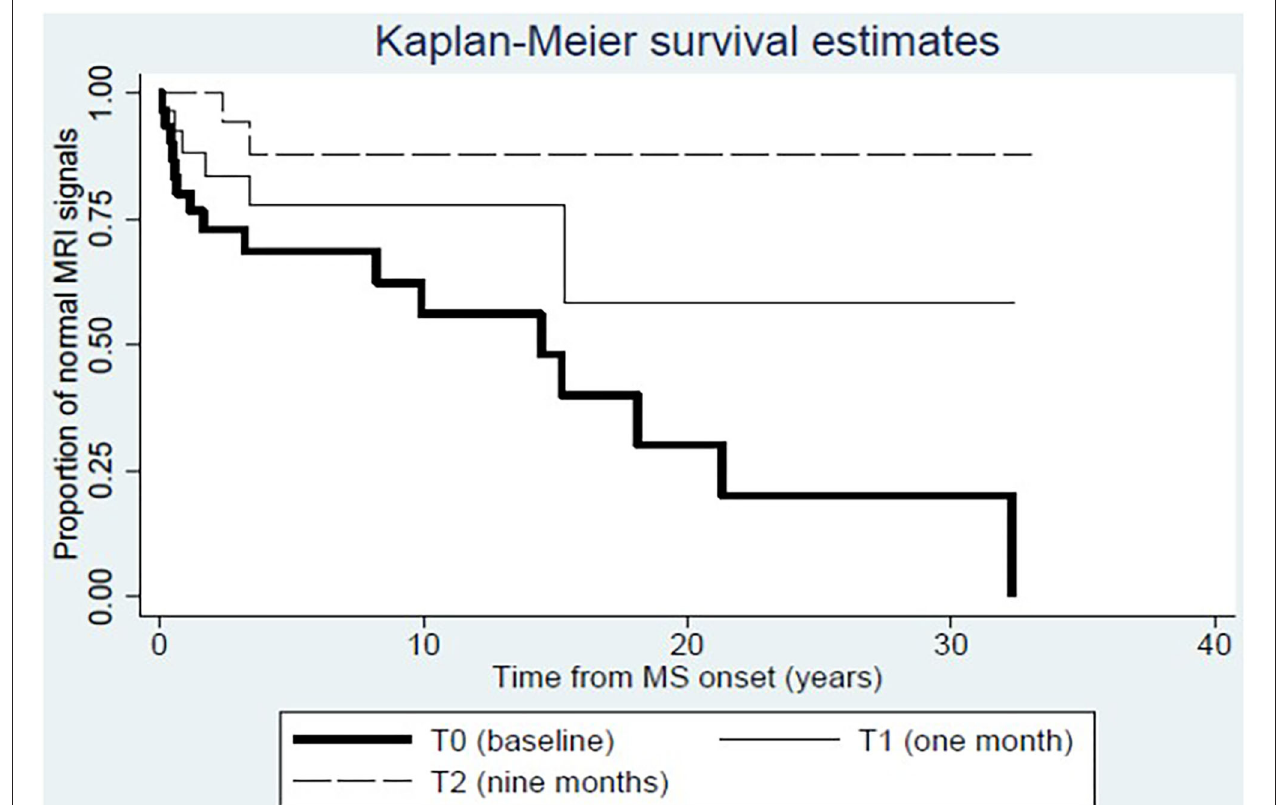
FIGURE 1 | Dynamics of disease activity at MRI before and after dimethylfumarate therapy. Kaplan–Meier estimates show that the proportion of patients with normal MRI signal increases at T1 and T2 compared to T0.